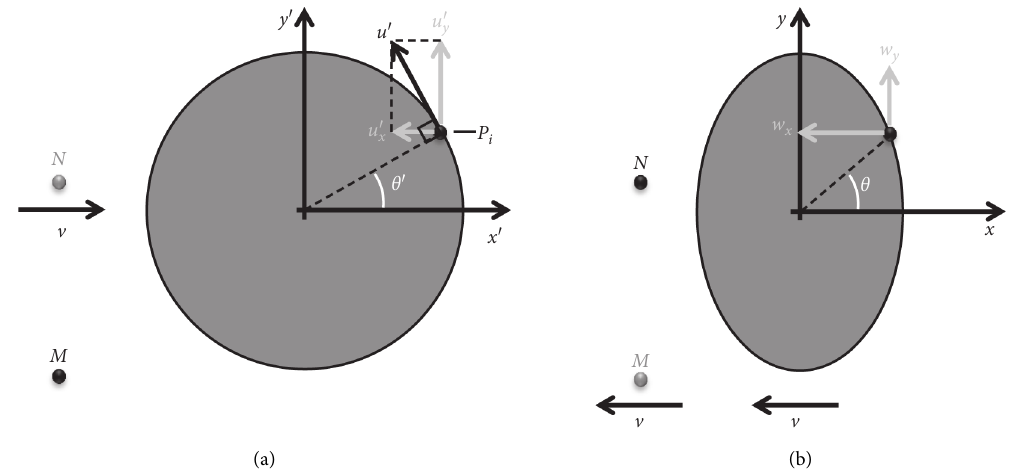
Figure 3: (a) The angular position of the i th P spring is shown as P M in plane x ′ y ′ . Because i on the plate being observed by the lab observer the tangential velocity of the plate’s perimeter is u ′ , the velocity of P i is decomposed to u x ′ and u y ′ . (b) The angular position of the spring as viewed by the moving observer N . The plate is Lorentz contracted due to its relative velocity of v . Indeed, N asserts that the velocity w of the i th spring has two components of w w x and y complying with the relativistic velocity addition